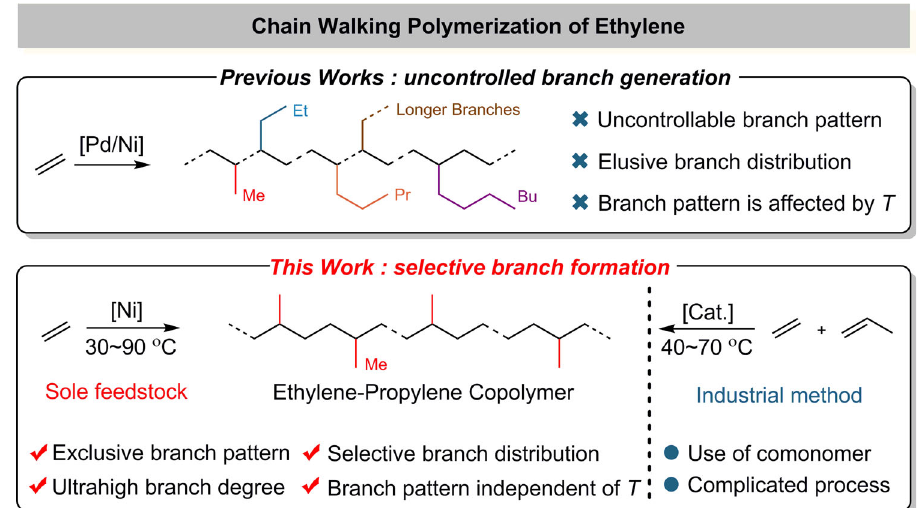
Fig. 1 Feature of chain walking polymerization of ethylene. A comparison on previous works and this work. Me: methyl; Et: ethyl; Pr: propyl; Bu: butyl; T :